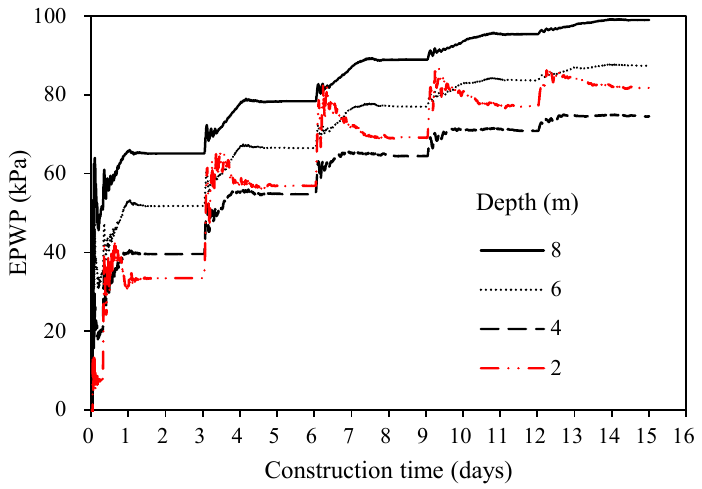
Figure 10. Variations in EPWP with construction time at the center of the surcharge loading region.